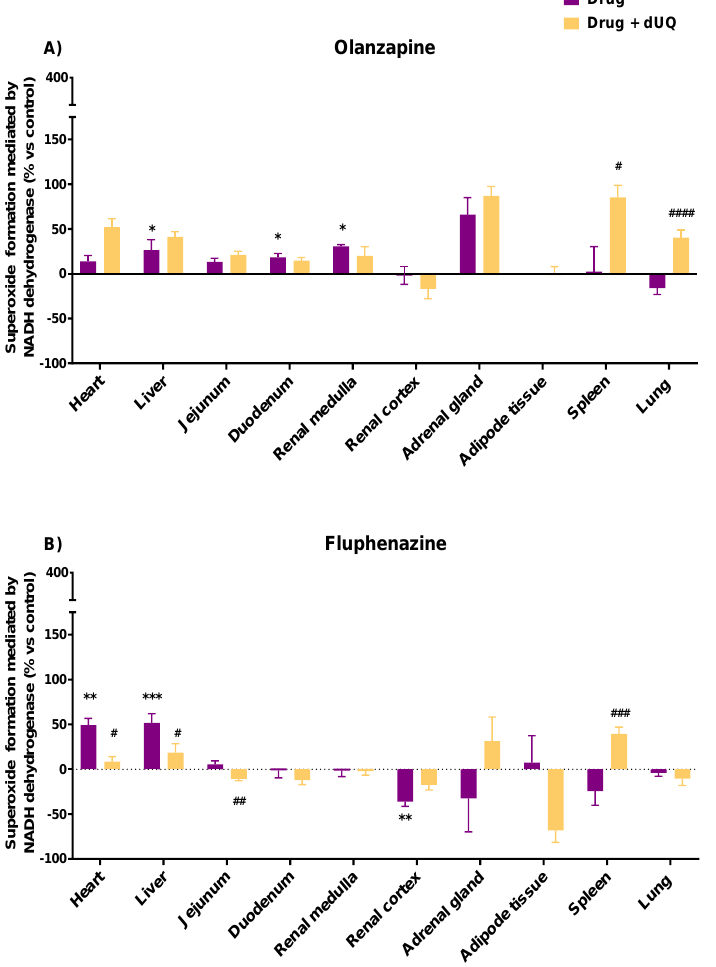
Figure 5. ( A ) NADH-mediated superoxide formation promoted by olanzapine in different human tissues in the presence and absence of decylubiquinone. ( B ) NADH-mediated superoxide formation promoted by fluphenazine in different human tissues in the presence and absence of decylubiquinone. Results expressed as percentages of increase versus the basal activity without the drug (mean ± SEM). Shapiro – Wilk test was performed to test normality. For the tissues that present a Gaussian distribution, one-way ANOVA statistical test with α : 0.05 was performed. For tissues without a normal distribution, Kruskal –Wallis statistical test with α: 0.05 was performed: * p < 0.05; ** p < 0.01; *** p < 0.001 drug vs. control; # p < 0.05; ## p < 0.01; ### p < 0.001; and #### p < 0.0001 drug alone vs. drug + dUQ.